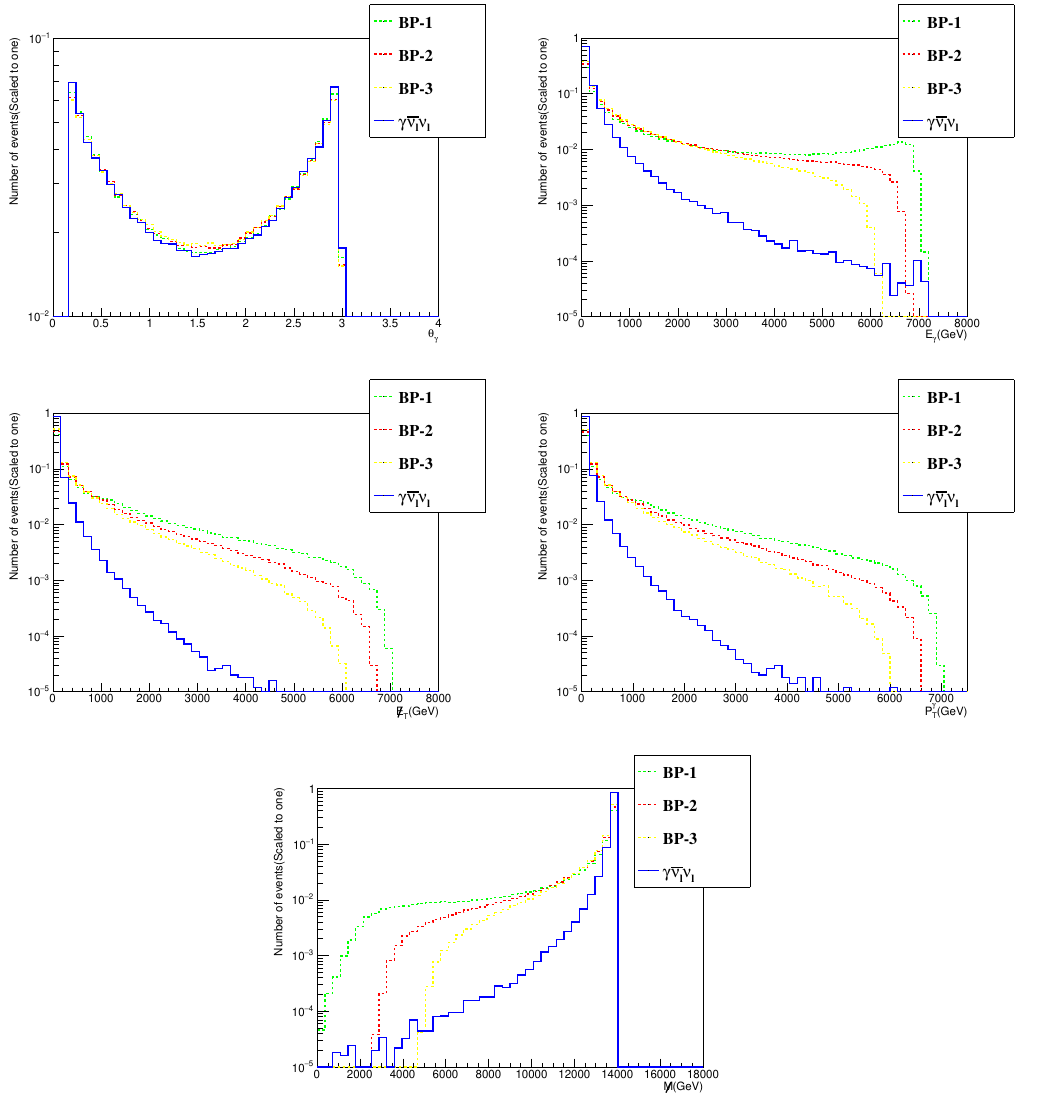
Figure 11 . Normalized distributions of the θ angle of photon θ γ (up-left panel), energy of the photon E γ (up-right panel), missing transverse energy (cid:0) E T (middle-left panel), transverse momentum of the photon P γ (middle-right panel), and missing mass (cid:26)(cid:26) M (down panel). T 80 fb. With the cuts shown in table 4, the cut efficiency for the scenario M = M / 2 1 η ± decreases from 0.12 to 0.03 when M increases. According to our simulation, no samples η ± are within the reach of 2 fb − 1 data. Provided an integrated luminosity of 200 fb − 1 , the 14 TeV MuC could discover the samples with σ ( γ + (cid:0)(cid:0) E ) & 10 fb, which corresponds to T | y | & 1 . 5 . The final 20 ab − 1 data would push the 5 σ discovery limit down to about 1 fb, 1 µ but is still hard to probe the | y | . 1 region in this mono-photon channel. 1 µ Fixing y = 0 . 02 , y = y = 2 , the 5 σ discovery limits on the M − M plane 1 e 1 µ 1 τ 1 η ± are shown in the right panel of figure 12. We do not find the corresponding 5 σ discovery . 3 TeV and M . 5 . 5 TeV is limit for 2 fb − 1 in this analysis. The region with M 1 η ± unrevealed by 200 fb − 1 data. Increasing the luminosity to 20 ab − 1 is able to cover